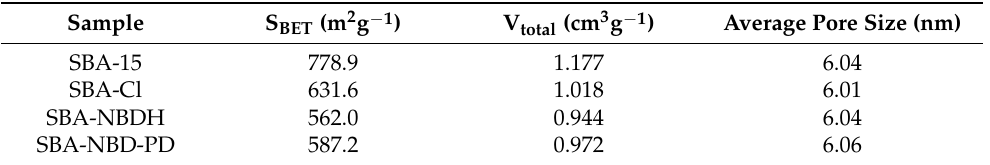
Figure 2. N 2 adsorption–desorption isotherms ( a ) and pore size distribution graphs ( b ) of the samples. Table 1. Textural parameters of the samples determined from the N 2 adsorption–desorption